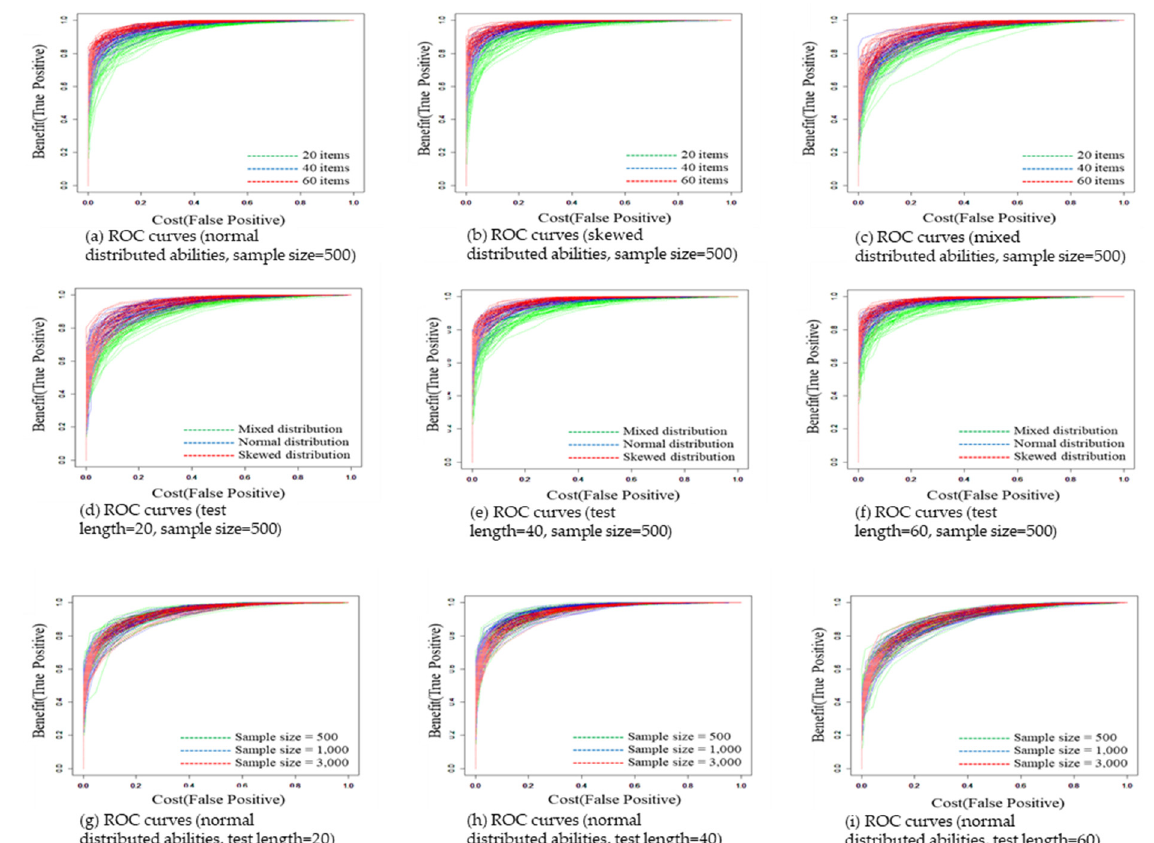
Figure 4. ROC curves change with different conditions